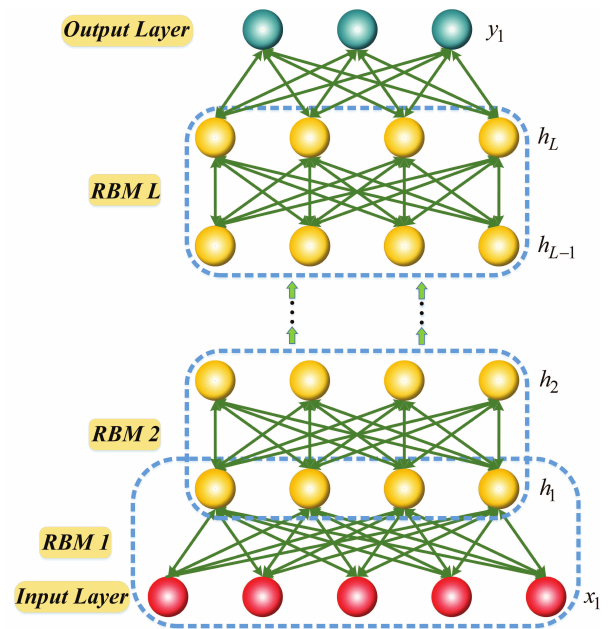
Figure 2. The structure of